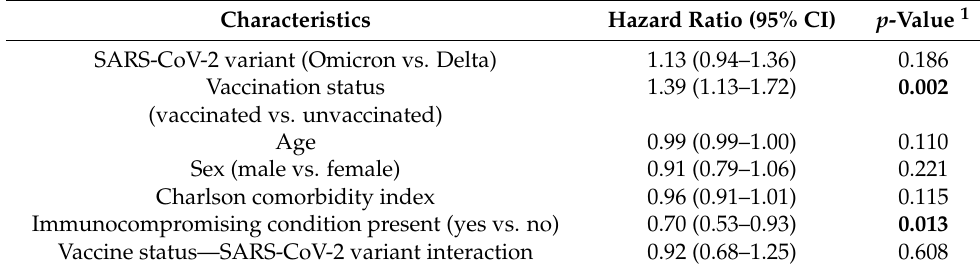
Table 3. Cause-specific hazard ratios for discharge from hospital.